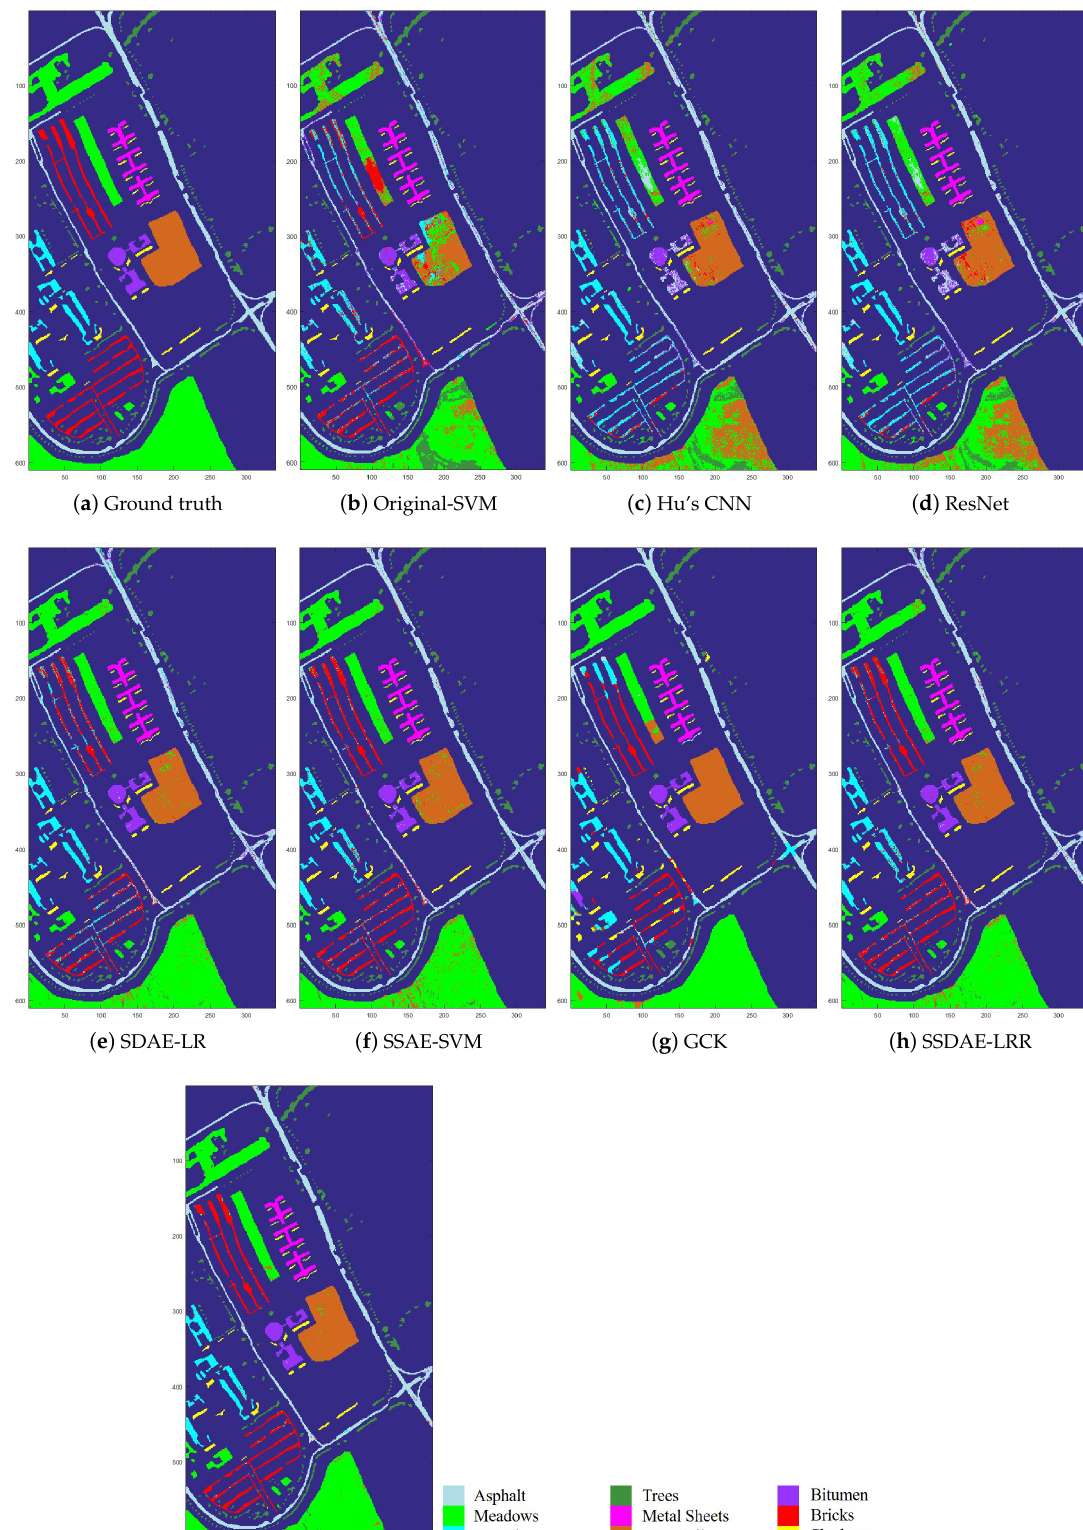
Figure 10. Classification maps of different methods on Pavia University dataset (a total of 100 labeled samples were used for